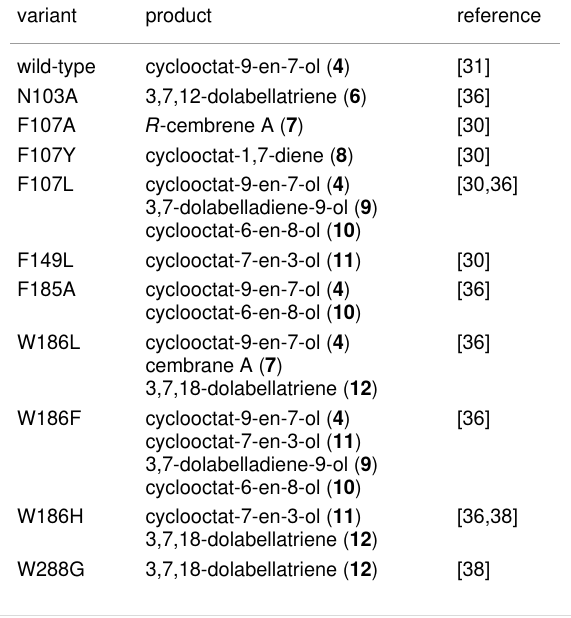
Table 2: CotB2 and its variants as well as the altered